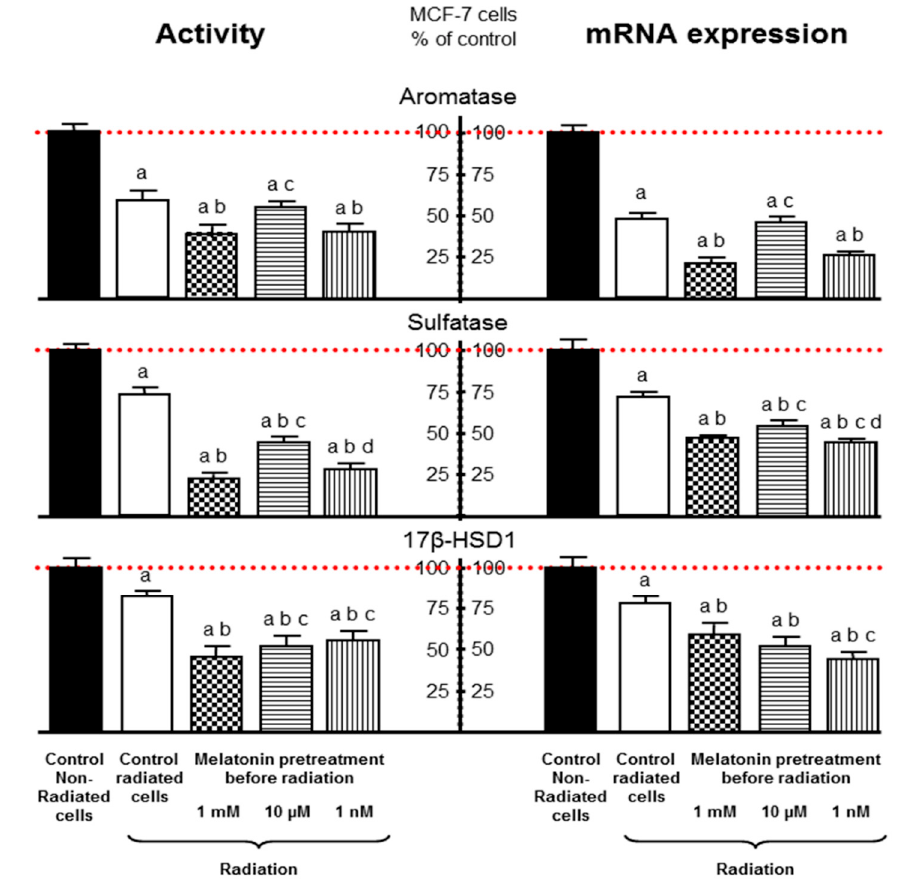
Figure 2. Modulation of proteins involved in estrogen biosynthesis. Melatonin pre-treatment (1 mM, 10 μ M or 1 nM) enhances the inhibitory effect induced by the radiation on aromatase, sulfatase and 17 β -HSD1 (17 β -Hydroxysteroid dehydrogenase) activity and expression of MCF-7 cells. Data are expressed as the percentage of the control non-radiated group (mean ± SEM). ( a ), p < 0.001 vs. control non-radiated cells; ( b ), p < 0.001 vs. control radiated cells; ( c ), p < 0.01 vs. 1 mM melatonin; ( d ), p < 0.001 vs. 10 µ M melatonin. Modified from Alonso-Gonz á lez et al.